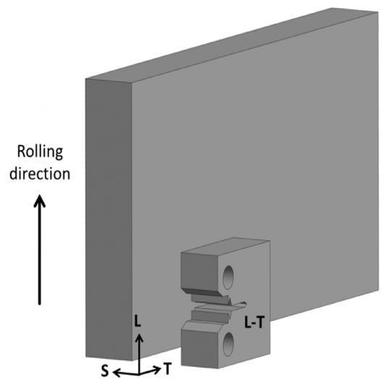
Cutting scheme of the 0.25T C(T) specimens from ODS_WQ_RT and ODS_AC_RT in the L-T orientation